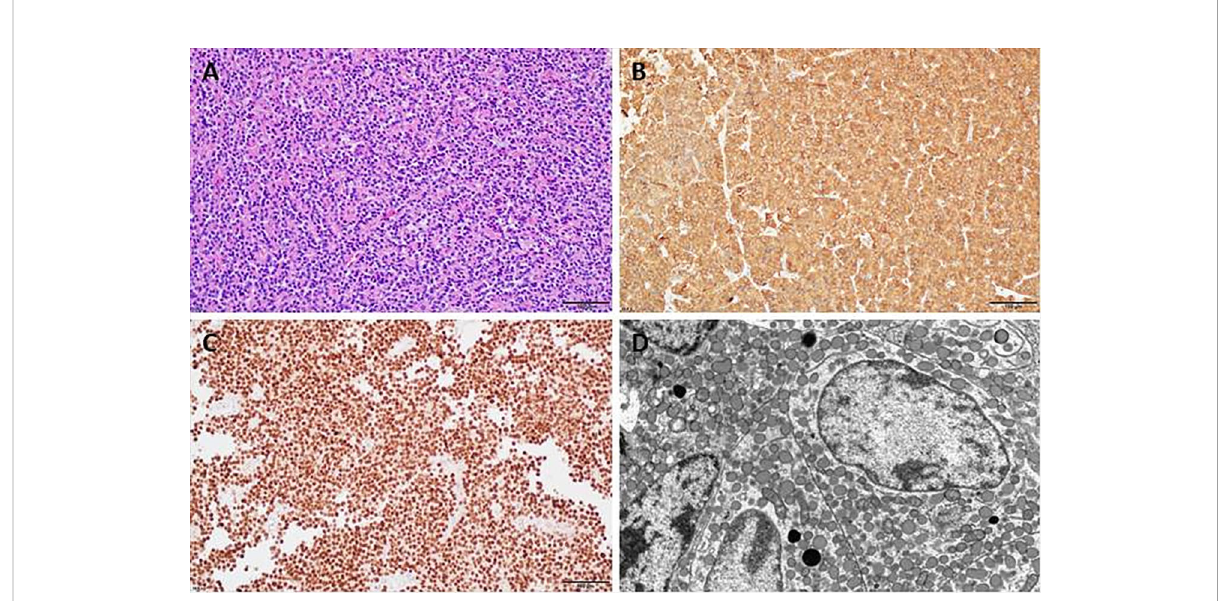
FIGURE 2 Densely granulated somatotroph pituitary adenoma (PitNET). (A) Histology of densely granulated somatotroph PitNET (HE), (B) Immunopositive staining for growth hormone (GH), (C) Immunopositive staining for PIT1, (D) Ultrastructural features of densely granulated somatotroph